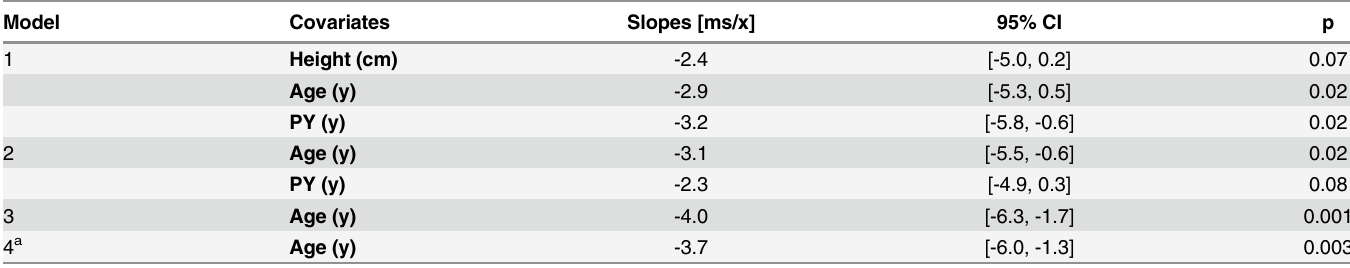
Table 2. Influence of covariates on T 1 for all subjects (n = 35).